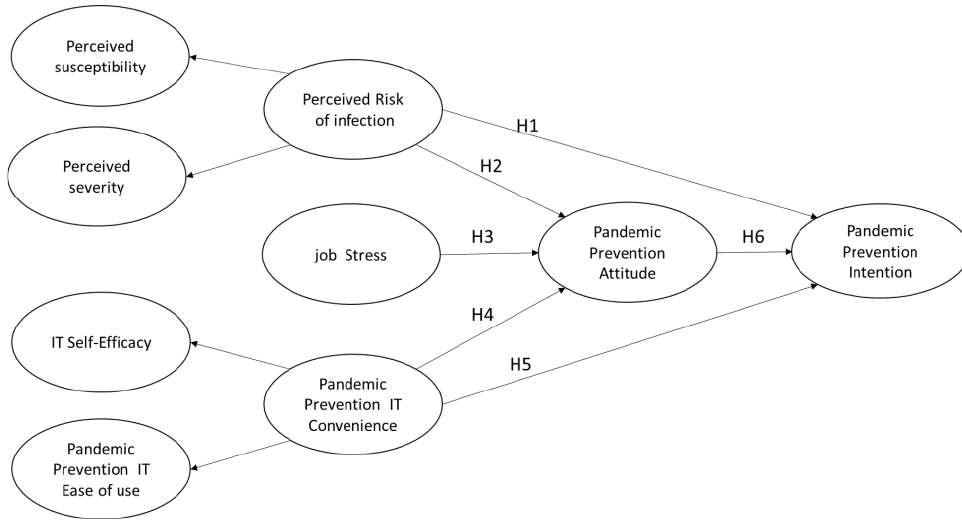
Figure 1. Research